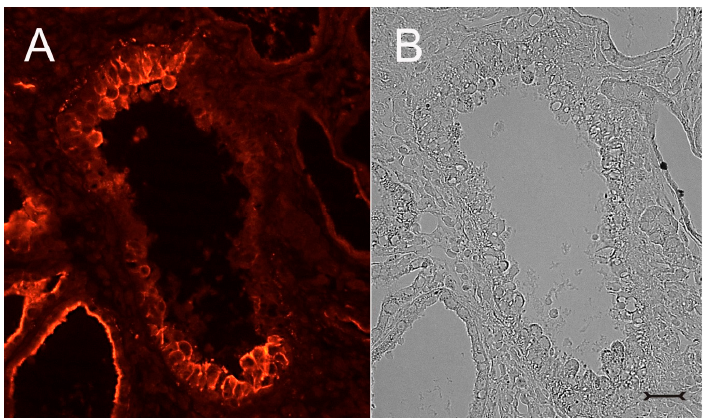
Figure 4. Immunohistochemistry for Kim-1 ( A ) and corresponding phase contrast micrograph ( B ) of a (cy/+) rat kidney cortex. An enlarged cyst with a hyperplastic cyst wall with portions strongly staining for Kim-1 ( A ). In the vicinity, another proximal cyst (bottom left) with continuous apical labeling. Bar = 15 µm.